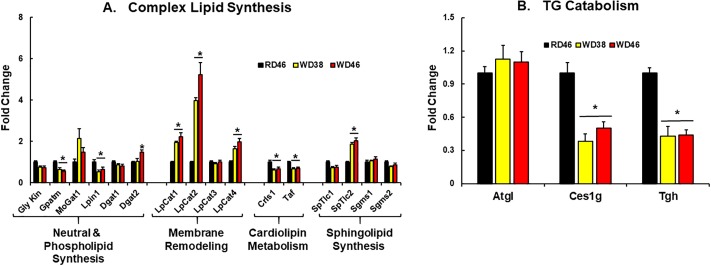
Western diet effects on the expression of enzymes involved in complex lipid synthesis (A) and TG catabolism (B). Transcript abundance was quantified as described above. Results are expressed as mRNA abundance, Fold Change; mean ± SEM, N = 7–8 samples, *, FDR < 0.05 versus the RD46 group. [A: Gly Kin, glycerokinase; Gpatm, glycerophosphate acyltransferase-mitochondrial; Dgat, diacylglycerol acyl transferase; LpCat, lysophosphatidyl choline acyltransferase; Crls, cardiolipin synthase; Taf, tafazzin; SpTlc, serine palmitoyl transferase long chain; Sgms, sphingomyelin synthase]; [B: Atgl, adipocyte triglyceride lipase, Ces1g, carboxyesterase-1g; Tgh, triglyceride hydrolase/Ces3].